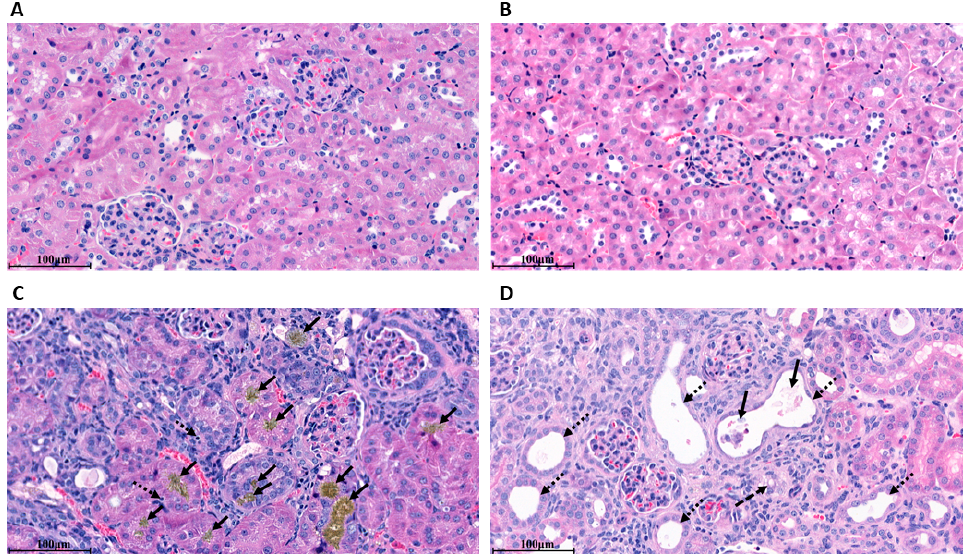
Figure 2. Representative light microscopy images of Hematoxylin-Eosin (H&E) staining of kidney tissues. ApoE KO mice were fed for 2 weeks with WD-CAC, followed by 5 weeks with WD-CAC ± adenine, and kidneys were harvested and processed for paraffin sections. ( A , B ) Two representative stainings of healthy kidney cortex sections with normal glomeruli and tubules. In adenine treated mice, the left panel ( C ) presents adenine crystal deposition (black arrow) and apoptotic cell nuclei (dotted black arrows), and the right panel ( D ), signs of acute tubular necrosis with dilated tubules (dotted black arrows), cell debris (fat black arrow), and tubular vacuolization (dashed black arrow). Scale bars = 100 μ m.